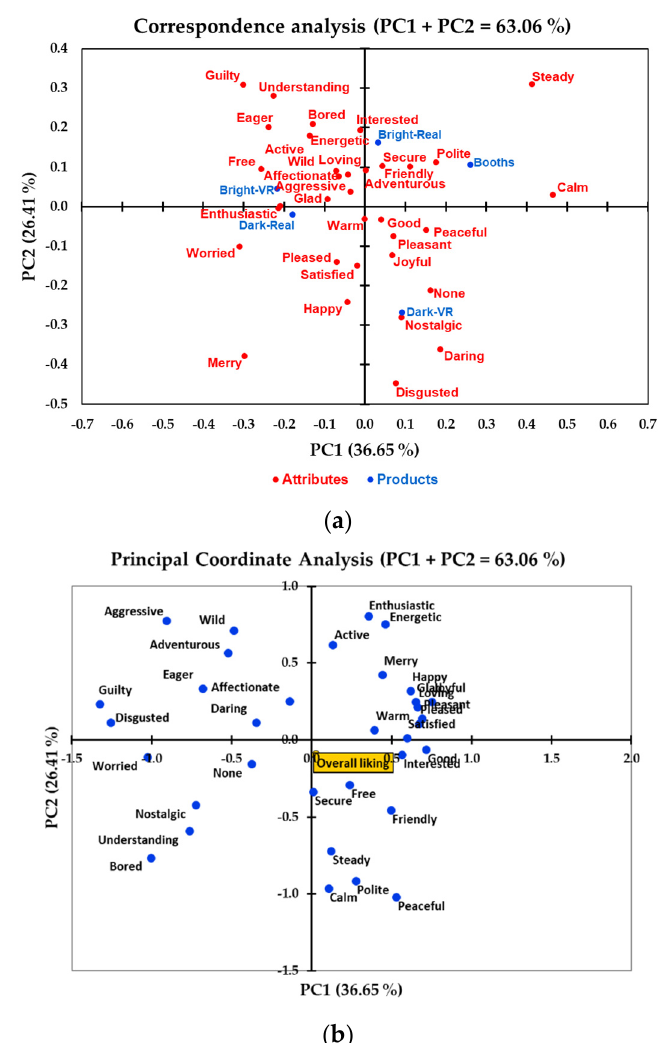
Figure 3. ( a ) Correspondence analysis of the emotion terms for the wine sample in each environment 1 and ( b ) principal coordinate analysis of the emotion terms with the overall liking score. 1 Booths = traditional sensory booths, Bright ‐ real = bright restaurant real environment, Dark ‐ real = dark restaurant real environment, Bright ‐ VR = bright restaurant VR environment, and Dark ‐ VR = dark restaurant VR environment.